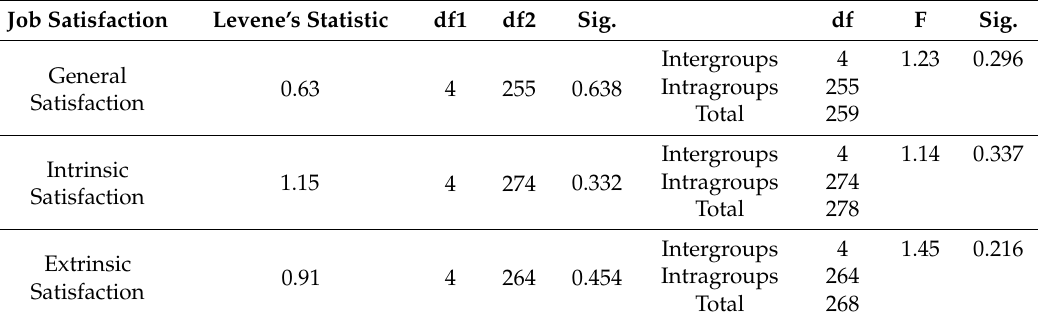
Table 1. Relationship between the general satisfaction dimensions and age.